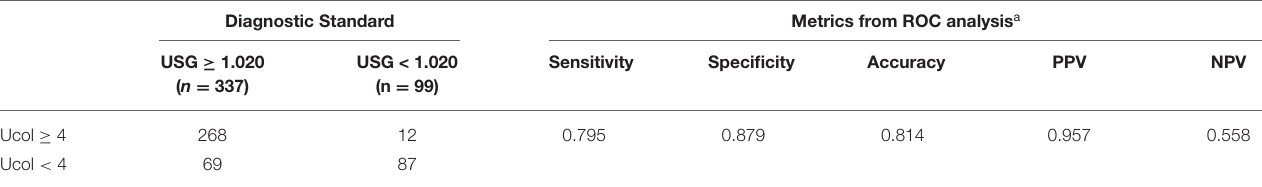
TABLE 7 | Urine samples classified according to USG and urine color (Ucol) values; followed by metrics from the receiver operating characteristic curve (ROC)